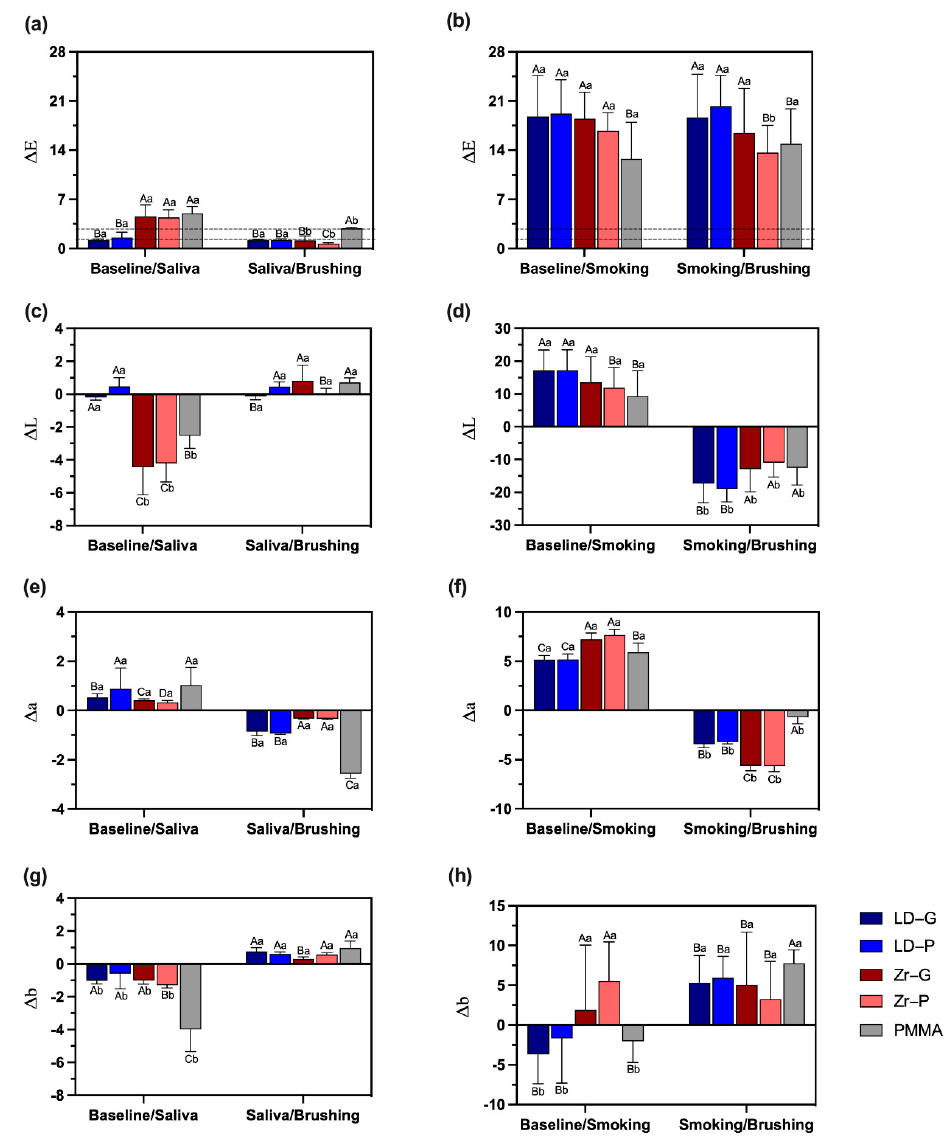
Figure 4. ∆ E, ∆ L, ∆ a, and ∆ b values according to the experimental groups ( n = 10) and moments of color measurement; ( a ) ∆ E values indicating sample color changes between soaking on saliva and baseline, lower dashed line representing the perceptibility threshold ( ∆ E = 1.2) and higher dashed line representing the acceptability threshold ( ∆ E = 2.7); ( b ) ∆ E values indicating sample color changes between brushing and after smoking, lower dashed line representing the perceptibility threshold ( ∆ E = 1.2) and higher dashed line representing the acceptability threshold ( ∆ E = 2.7); ( c ) ∆ L values indicating sample color changes between soaking on saliva and baseline; ( d ) ∆ L values indicating sample color changes between brushing and after smoking; ( e ) ∆ a values indicating sample color changes between soaking on saliva and baseline; ( f ) ∆ a values indicating sample color changes between brushing and after smoking; ( g ) ∆ b values indicating sample color changes between soaking on saliva and baseline; ( h ) ∆ b values indicating sample color changes between brushing and after smoking. Dissimilar letters indicate statistically significant differences (one-way repeated measures ANOVA). Capital letters compare different surfaces within the same moment of evaluation (baseline, saliva/smoking, or brushing). Lower case letters compare the same surface at different moments. Lithium disilicate glazed (LD-G), lithium disilicate polished (LD-P), zirconia glazed (Zr-G), zirconia polished (Zr-P), and Telio PMMA